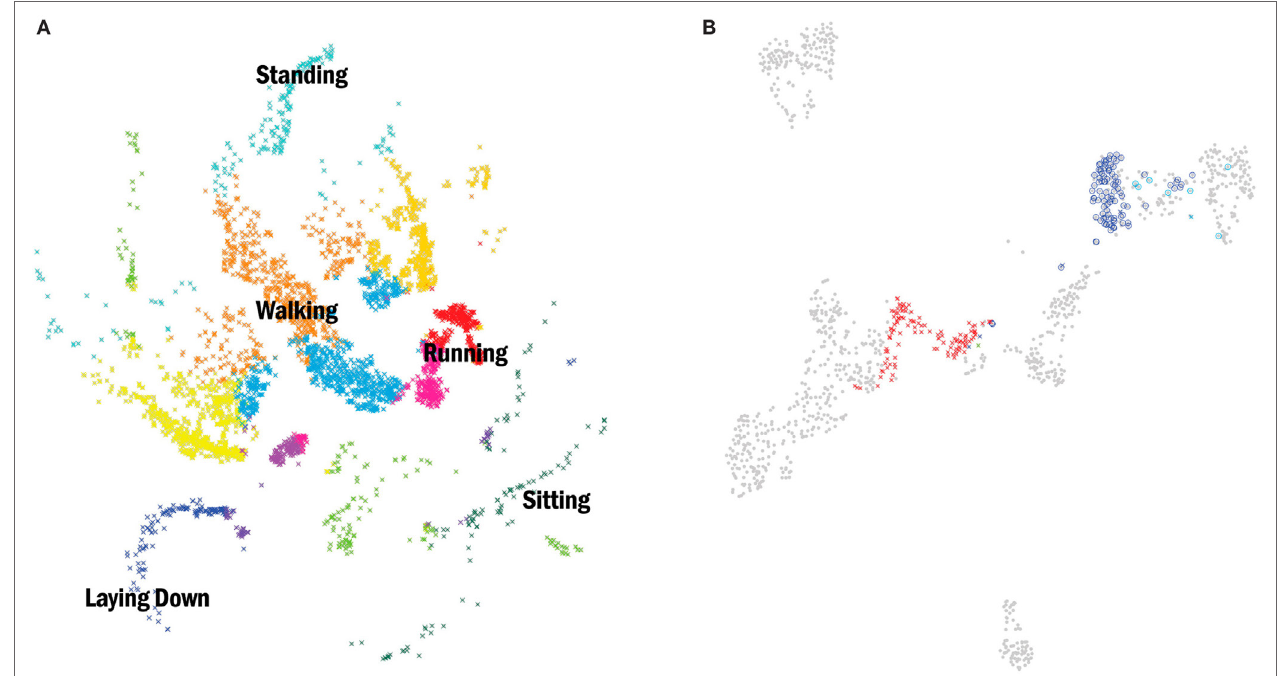
FiGUre 1 | (A) (Left) two-dimensional embedding (t-Distributed Stochastic Neighbor Embedding) (50) of acceleration data points from nine healthy subjects performing several daily activities. Data were collected with one inertial measurement unit (IMU) placed over the pelvis with a sample rate of 120 Hz. Each point corresponds to a discretized behavior block obtained with a change-point detection algorithm. Colors correspond to clusters obtained by affinity propagation (51). A subset of clusters was labeled according to the dominant feature (standing, walking, sitting, etc.). (B) (Right) shows an example of the same methodology now applied to six patients diagnosed with idiopathic Parkinson’s disease (PD) and a Hoehn and Yahr stage less than or equal to 2. Movement data were collected with one IMU placed over the pelvis (sample rate 120 Hz) while patients walked a 10-m corridor, first in their OFF state (“x”) and later in their best ON state defined by the Movement Disorder Society Unified Parkinson’s disease rating scale (“o”). The gray dots represent all the recorded blocks of behavior from the six PD patients and the color dots the groups related to one patient. Clusters represented in both left and right images are from two independent experiments, thus, the resultant embeddings are not